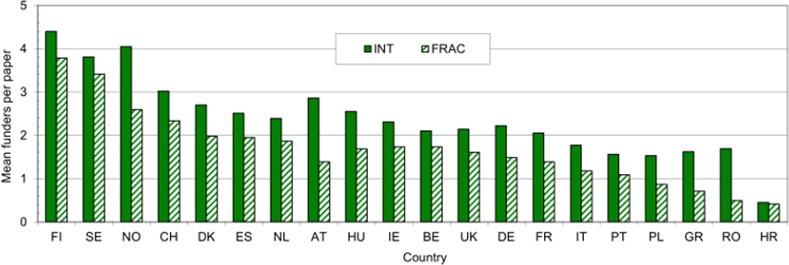
Mean numbers of funding acknowledgments per paper, explicit and implicit, on the basis of integer paper counts (INT) and of fractional counts (FRAC) for the 20 leading European producers of RESPI papers, 2009–13.